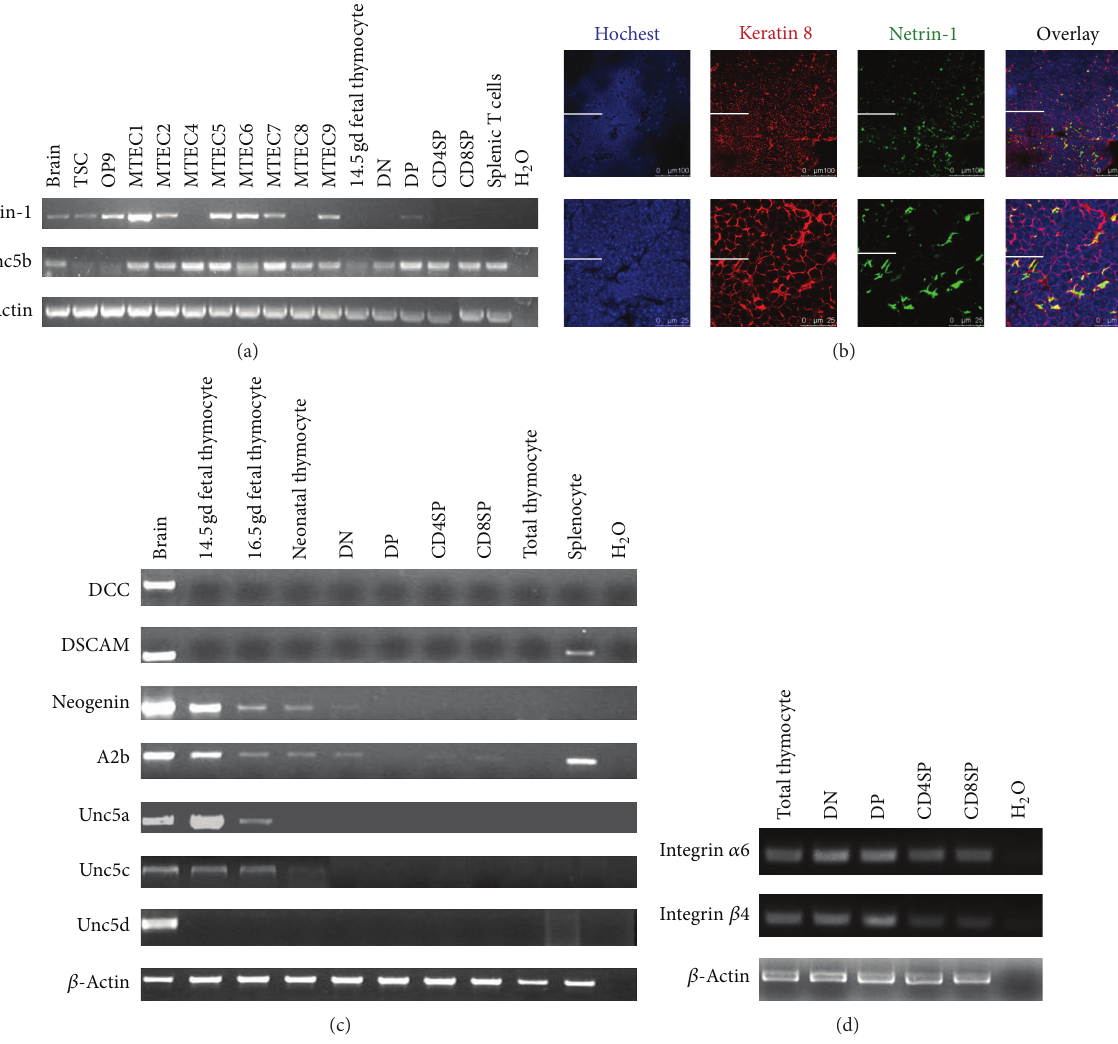
Figure 1: Expression of Netrin-1 and the corresponding receptors in the mouse thymus and thymic cell types. (a) RT-PCR detection of Netrin-1 and Unc5b mRNA expression in the indicated cells. (b) This depicts a section of mouse thymus for the immunofluorescent staining of Keratin 8 (red) and Netrin-1 (green). The microscopic field shows that both molecules are largely colocalized in the thymus. Bars in the above and bottom panels are 100 𝜇 m and 25 𝜇 m, respectively. ((c) and (d)) RT-PCR detection of other receptors’ mRNA expression in the indicated cells. Brain: positive control; TSC: thymic stromal cell; OP9: bone-marrow-derived stromal cell; MTEC: medullary thymic epithelial cell; DN: double negative thymocyte; DP: double positive thymocyte; CD4SP: CD4 single positive thymocyte; CD8SP: CD8 single positive thymocyte; H 2 O: negative